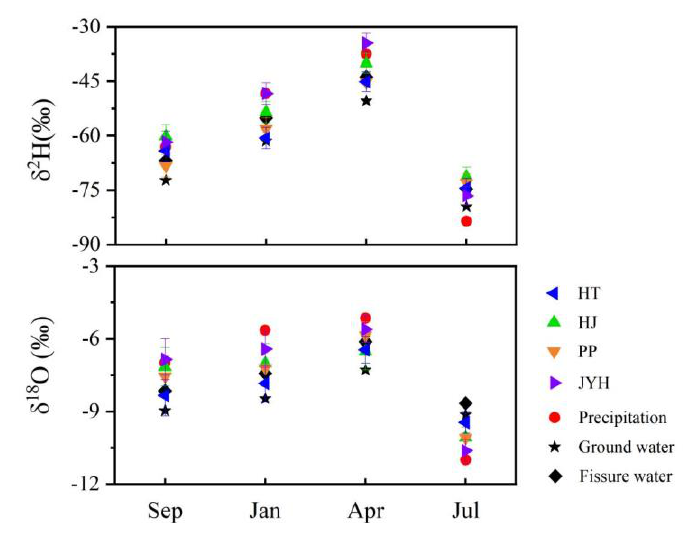
Figure 3. Seasonal variation of δ 2 H and δ 18 O values in xylem water of different water bodies and four plant species. The error bar represents the standard deviation. The δ 2 H and δ 18 O in rainwater represent the values of weighted averages per month.